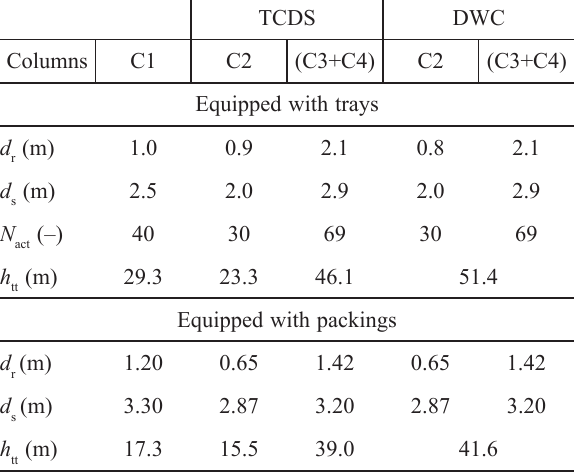
Table 3 – Shell diameters and heights of conventional de- methanizer and columns in a thermally coupled direct sequence (TCDS) and DWC configuration, equipped with trays and structured packing TCDS DWC Columns C1 C2 (C3+C4) C2 (C3+C4) Equipped with